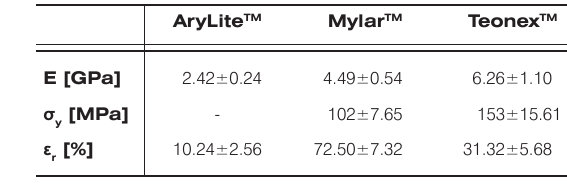
Table 3. Thermal properties of Arylite TM , Teonex TM and Mylar TM . AryLite